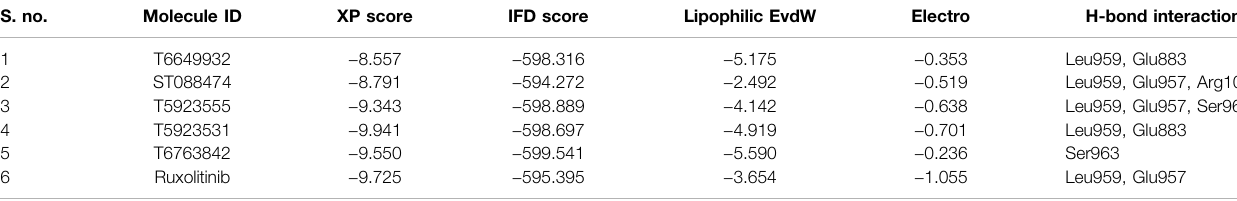
TABLE 9 | Induced fi t docking results of the selected JAK1 lead compounds and the drug. S. no.